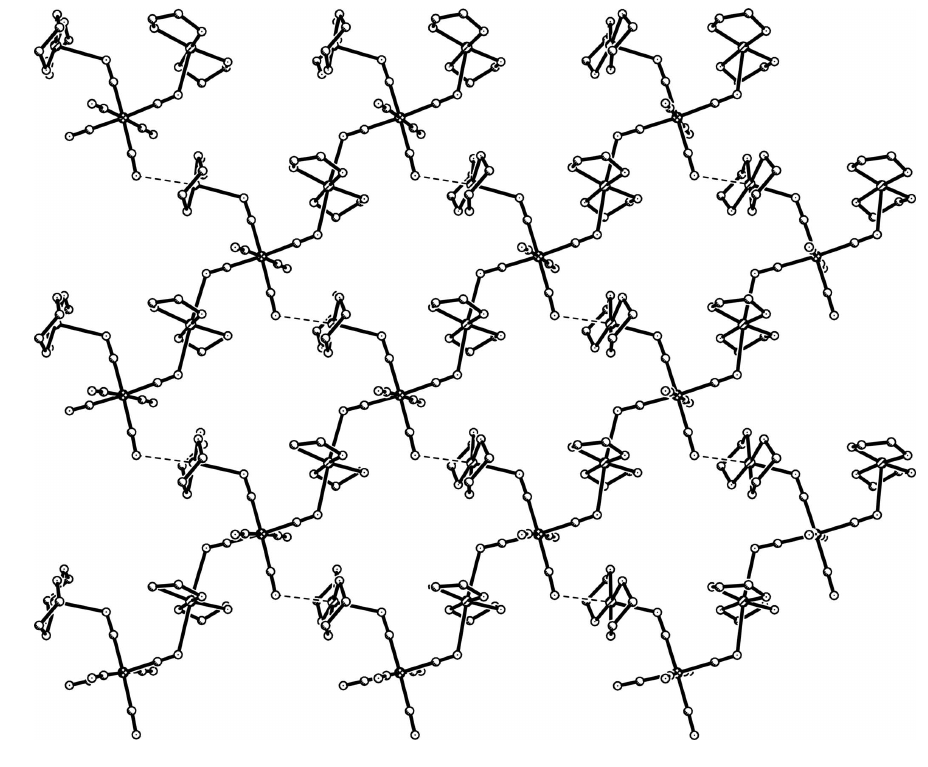
Figure 1 A view of the asymmetric unit of (I), with atom labels and 50% probability displacement